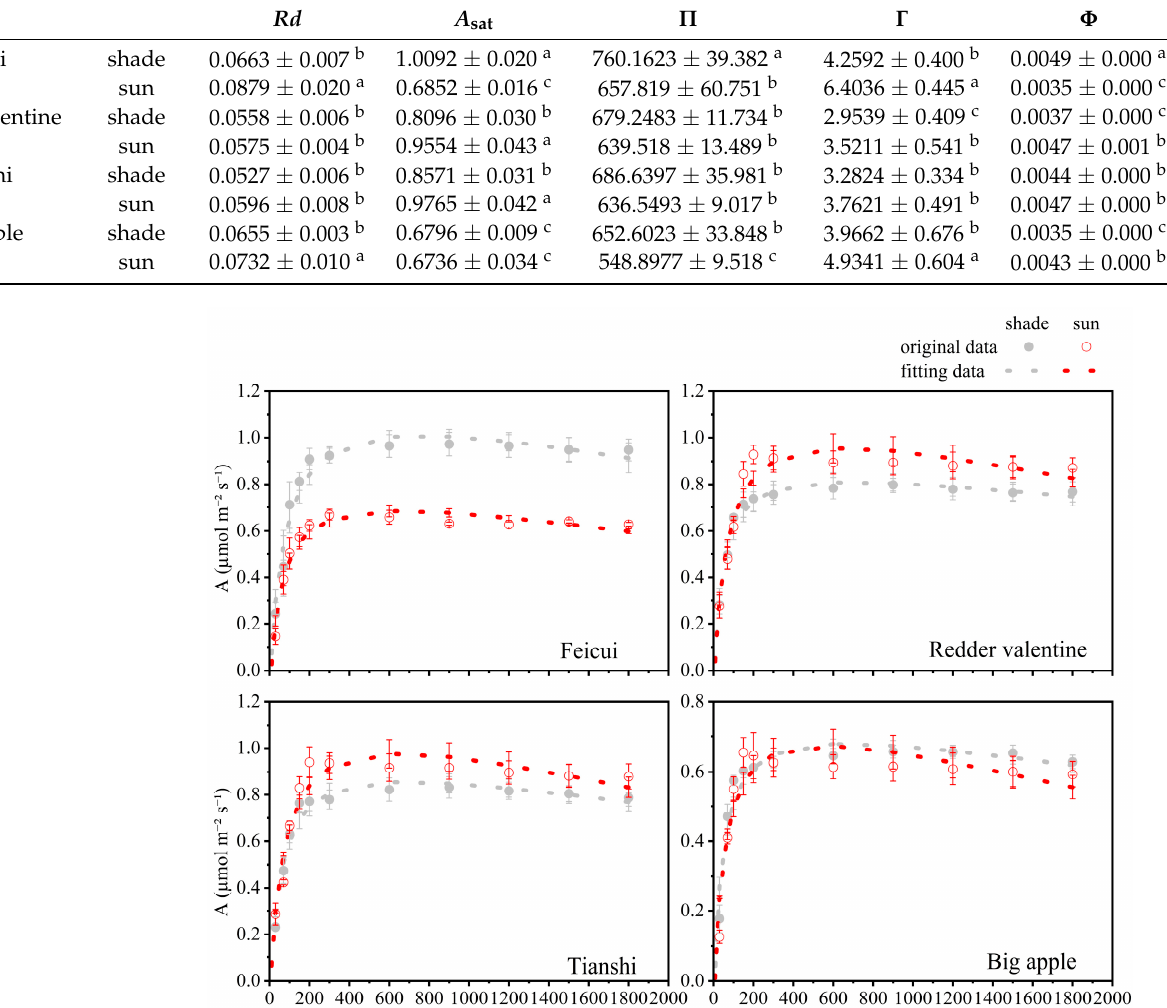
Table 1. Photosynthetic light response parameters of leaves of Feicui, Redder valentine, Tianshi, and Big apple grown in sun or shade. Data represent the mean ± SD (n = 3). Different lowercase letters in the same column indicate a significant difference ( p < 0.05, Duncan’s multiple range test).